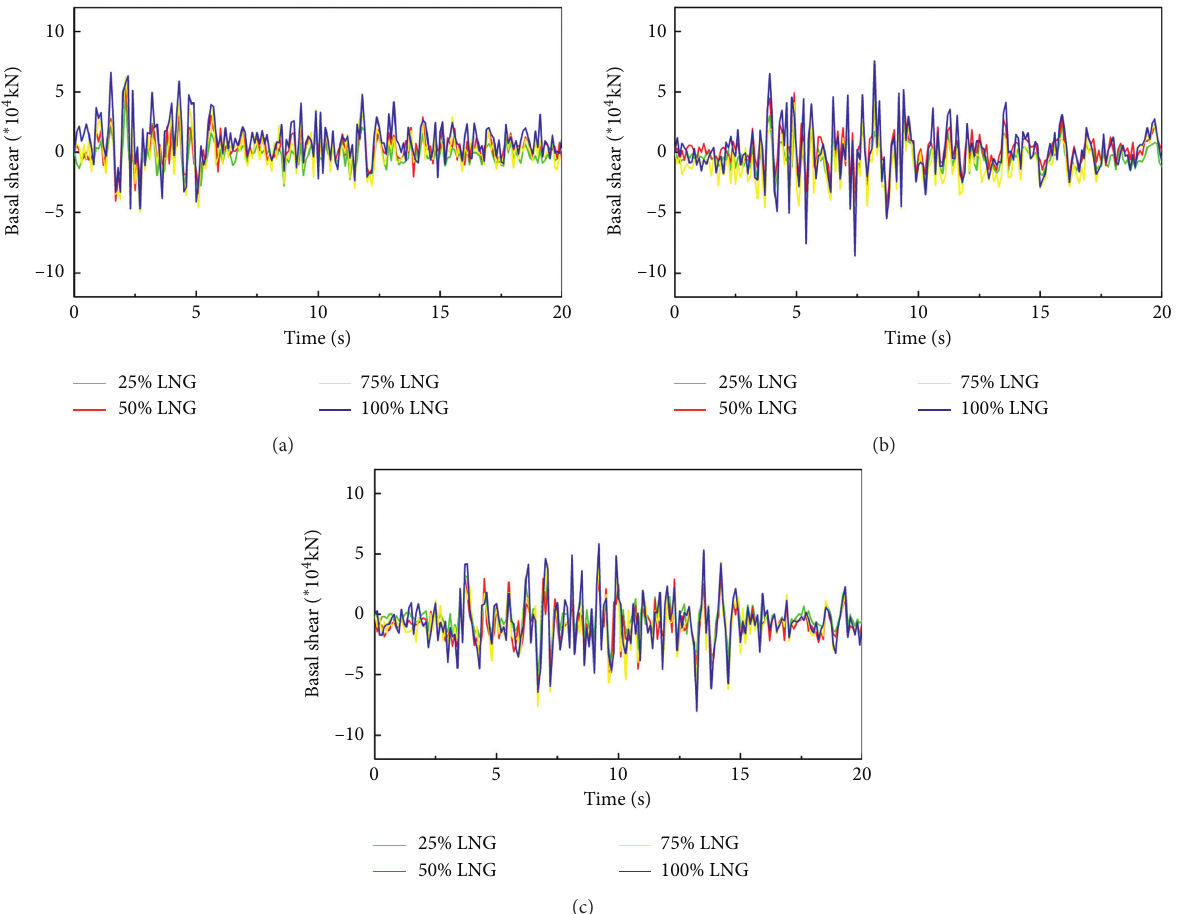
Figure 16: Base shear of the tank under different liquid volume. (a) El Centro, (b) Northridge, and (c) Taft.